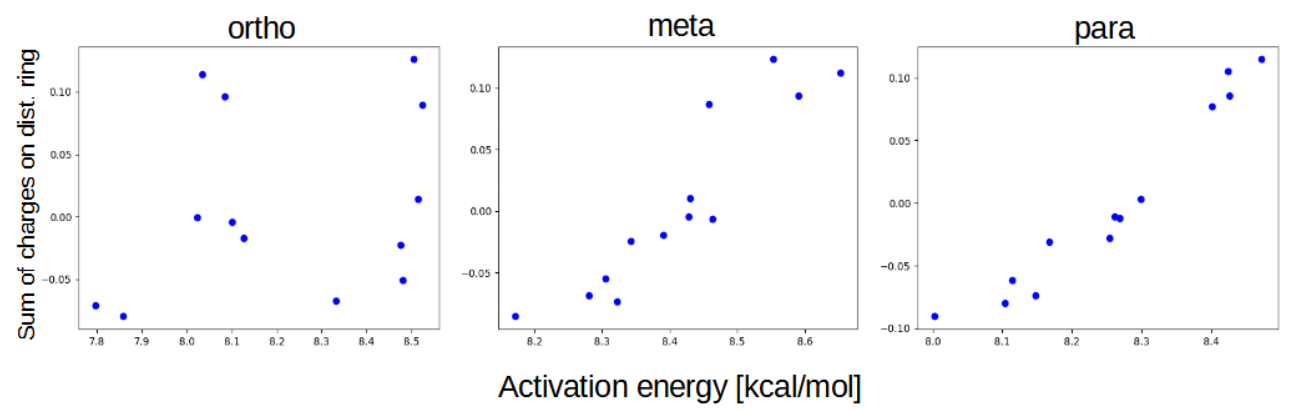
Figure 9. Relationship between the sum of the charges on the distal ring and the activation energy of the proton transfer for different groups of